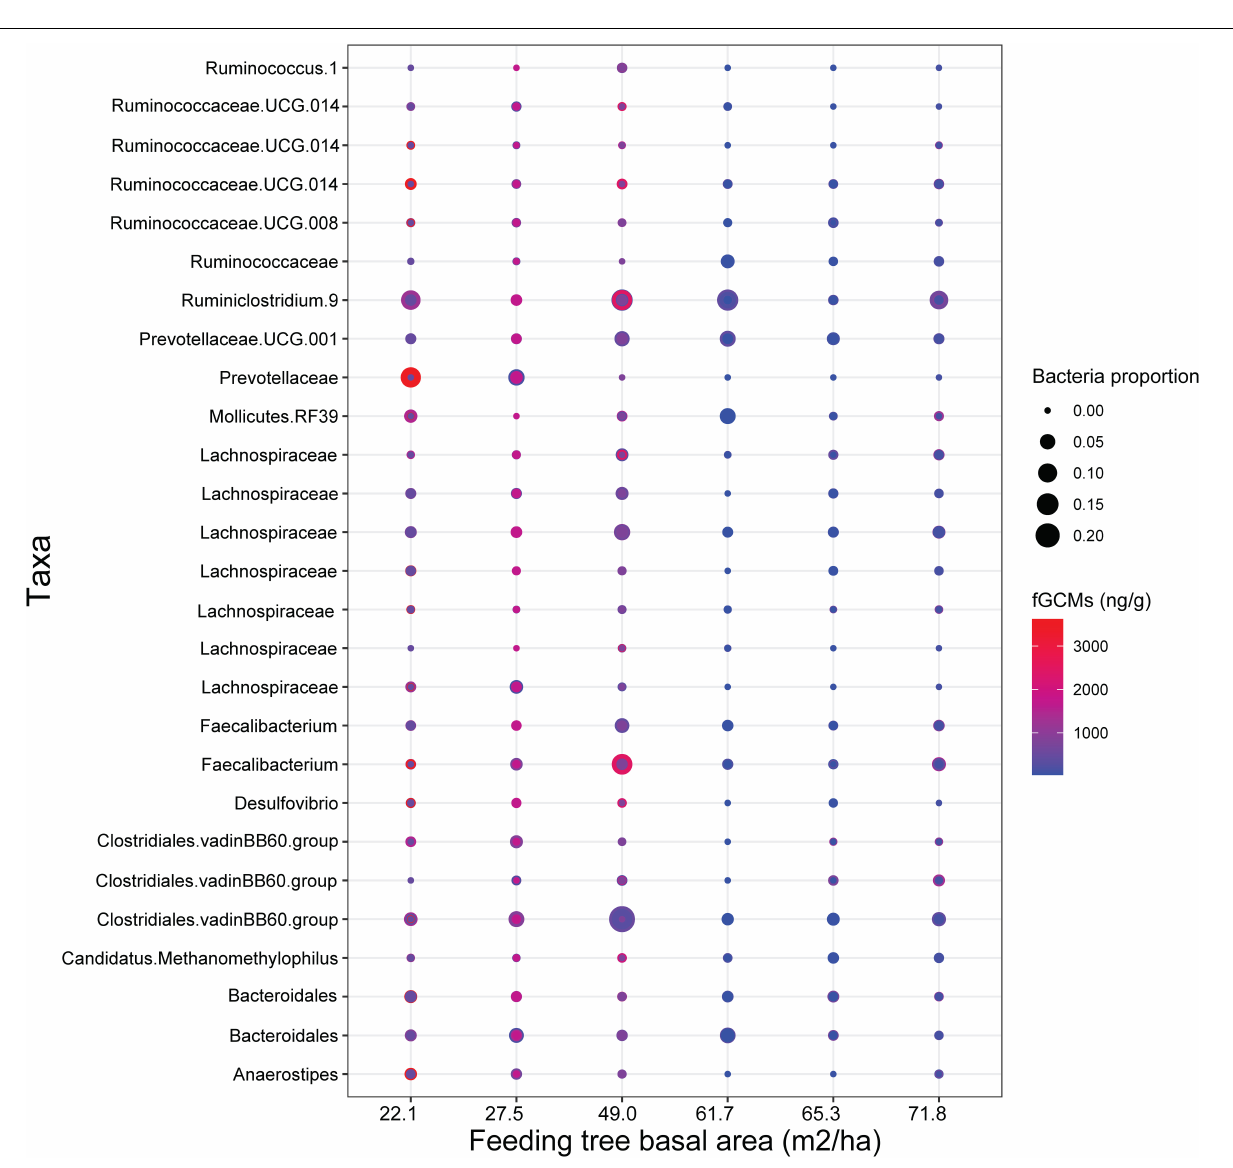
FIGURE 4 | Changes in proportional abundance of bacterial taxa related to fecal glucocorticoid metabolites of black howler monkeys ( Alouatta pigra ) and to variation in feeding tree basal area. The increase in bacterial abundance is represented by size of dots, and changes in fGCM levels are represented from color transition from blue to